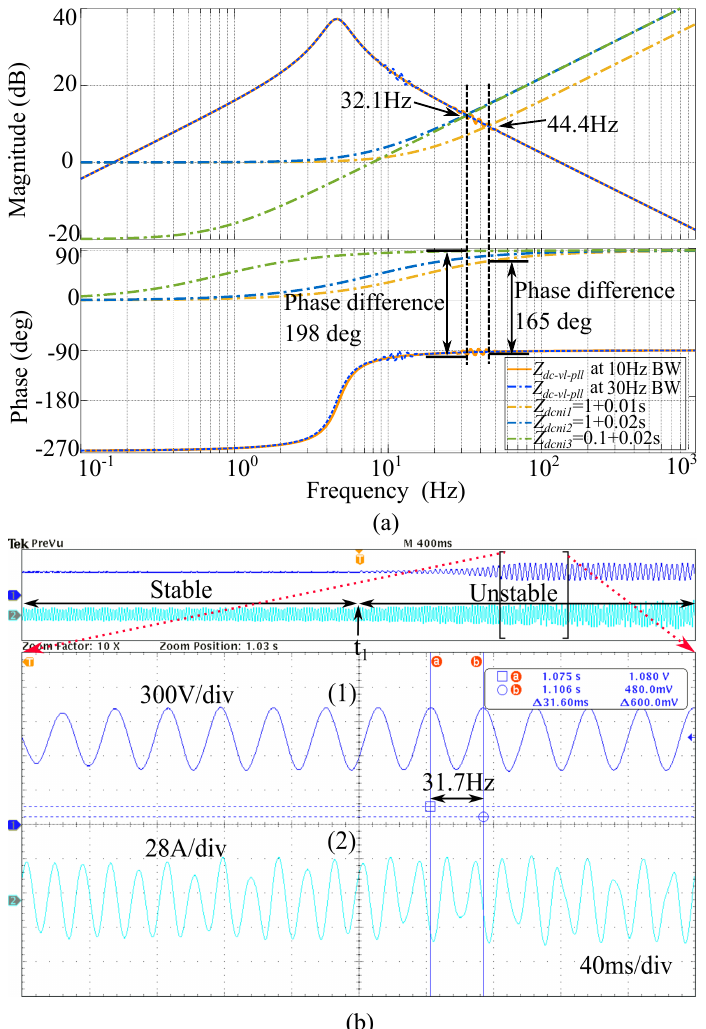
Figure 10. The converter is operating in a closed loop DC link voltage control mode ( a ) A Bode plot shows the DCIM characteristics with various DCNIs, ( b ) test result with DCNI: (1) DC link voltage, (2) grid